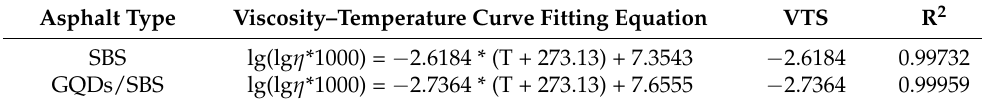
Table 4. Viscosity–temperature curve fitting equation of SBS and GQDs/SBS composite-modified asphalt. Asphalt Type